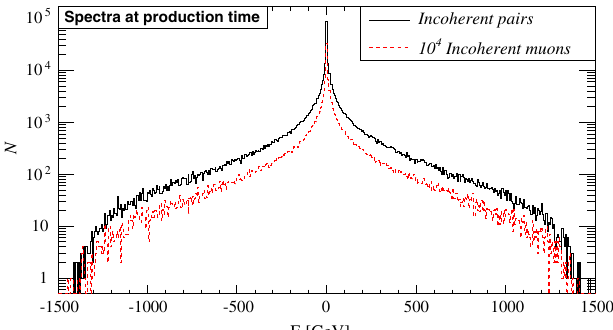
FIG. 19. Spectrum of incoherent muons at the time of pro- duction. The sign of the energy corresponds to the muon charge sign. The muon cross section is scaled up by a factor 10 4 , taking ð m =m Þ 2 ¼ 4 × 10 4 into account, to decrease simulation time. μ e